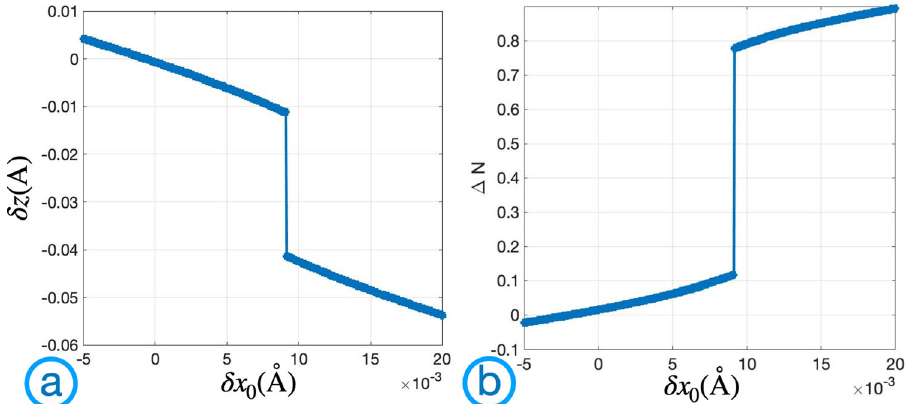
Fig. 9 Structural and electronic disproportionation of Ca 2 RuO 4 versus epitaxial strain. Equilibrium electronic order parameter characterizing the orbital polarization Δ N ( a ) and Ni – O apical bond distortion δ z ( b ) versus epitaxial strain de fi ned as the difference in mean in-plane Ru – O bond length relative to the value in the high temperature structure of Ca 2 RuO 4 as imposed through epitaxial strain via in-plane Ni – O bond changes away from the bulk values, δ x 0 , δ y δ x = δ y 0 where 0 0 , computed as described in the